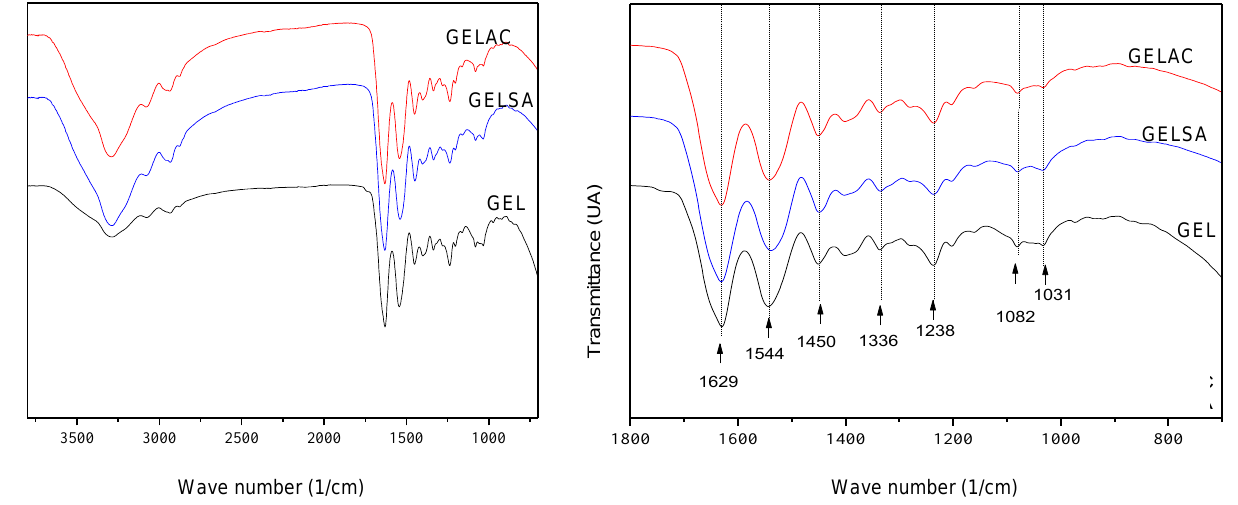
Figure 8. Infrared absorption spectra of GEL, GELAC, and GELSA biomembranes (left-hand side), with detailed analysis of the main peaks (right-hand side).